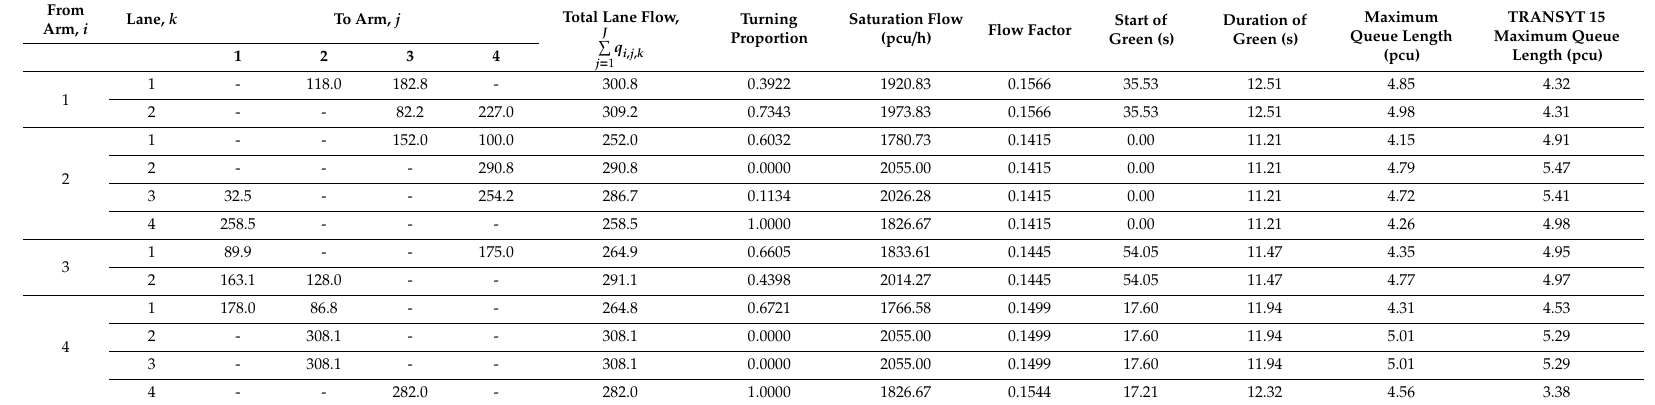
Table 3. Details of optimization results in the o ff -peak period with cycle time = 71.52 s and common flow multiplier = 1.207. From Arm,